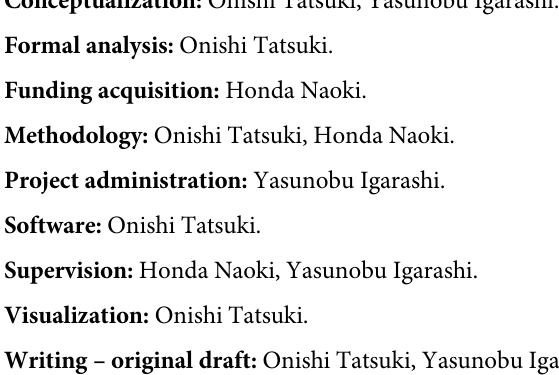
S1 Fig. Sensitivity analyses of parameters b and u on the number of cumulative deaths. Simulations were performed using different values of b and u . S2 Fig. Sensitivity analyses of d were performed using different values of d standard; (0.01, 0.001) means advance in treatment; (0.01, 0.01) means futile treatment; and (0.001, 0.0007) means reduction in overall mortality. S3 Fig. Sensitivity analyses of parameter a on the number of cumulative deaths. Simula- tions were performed using different values of parameter a